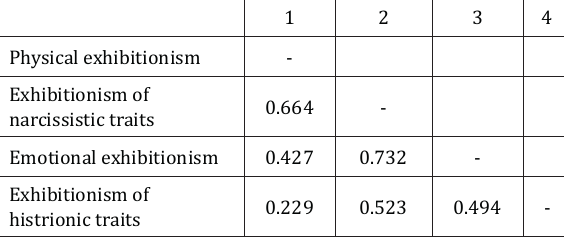
Table 4. HTMT values for differential validity of media